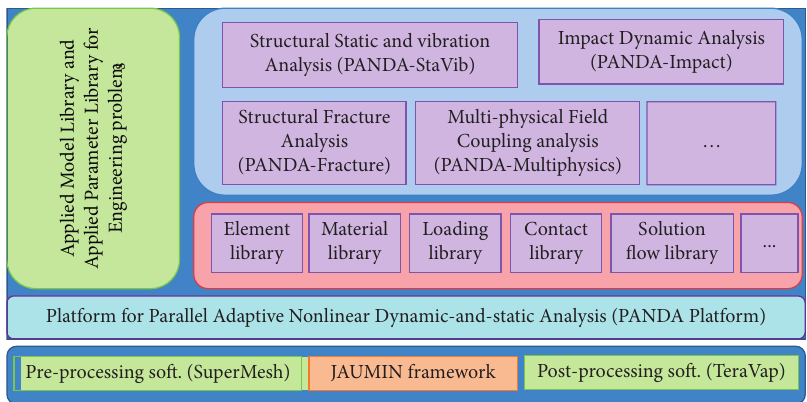
Figure 3: The PANDA platform and its relationship with the JAUMIN framework.